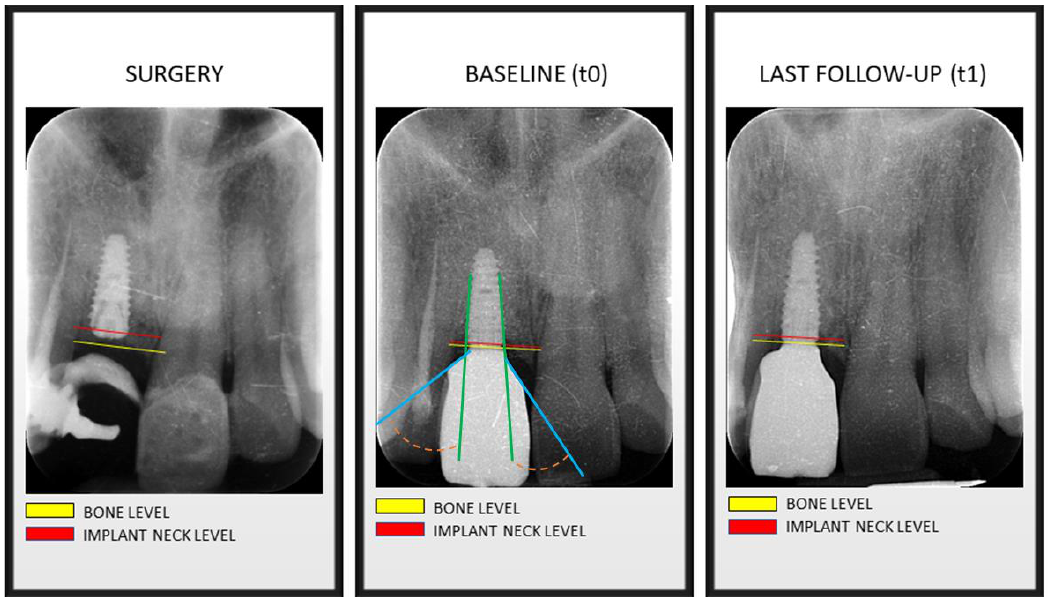
Figure 2. Bone levels at time of implant surgery, at prosthesis installation (baseline) and at last follow-up visit. Green line: implant axis. Blue line: prosthetic emergence profile axis. Orange line: angle between implant axis and prosthetic emergence profile >30 ◦ , determining the allocation in Group